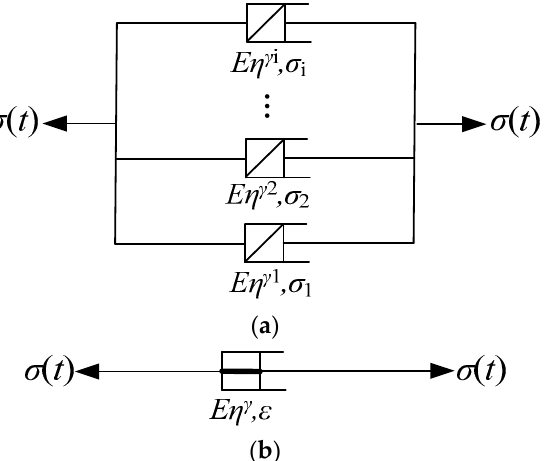
Figure 1. Model of the distributed order damper. ( a ) Standard form of the distributed order damper, ( b ) Simpli fi ed form.